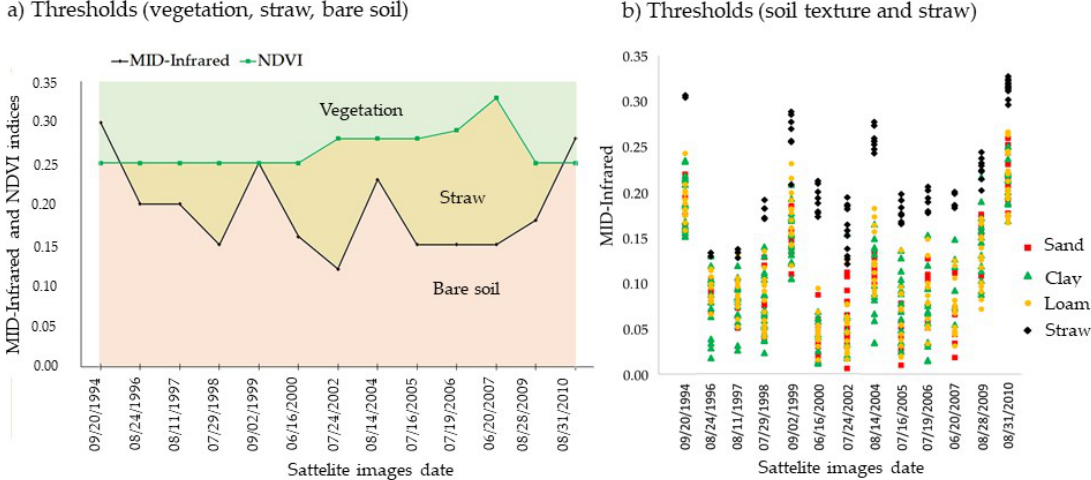
Figure 4. ( a ) MID-Infrared index and Normalized Difference Vegetation Index (NDVI) index thresholds from each satellite image for the model of bare soil, and ( b ) MID-Infrared index behavior from each image in soil texture and crop residues. image in soil texture and crop